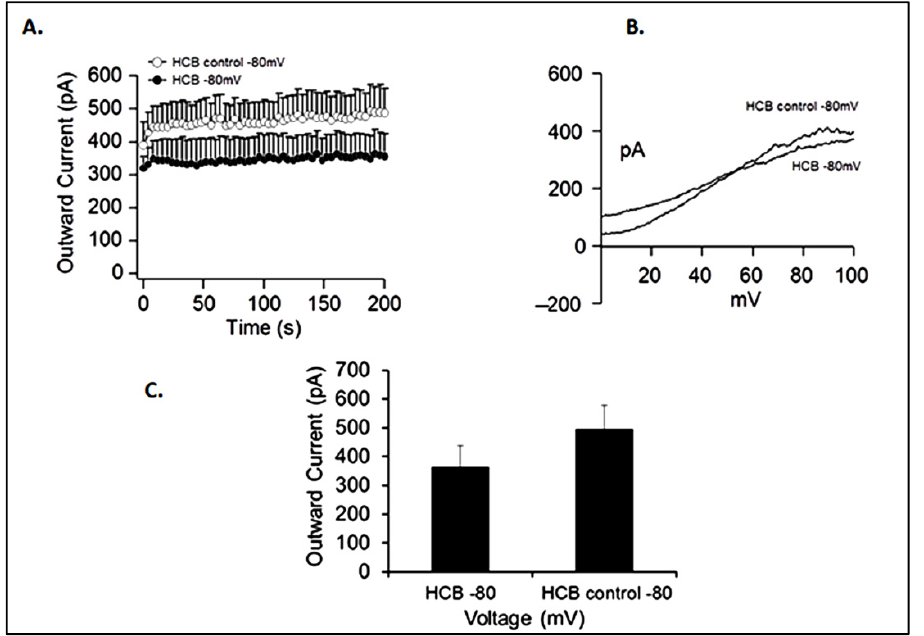
Figure 6. Effect of HCB on voltage-gated delayed rectifier K + currents in neurons obtained after encapsulation. ( A ) Average outward currents recorded from controls and HCB 0.5 nM treated cells extracted at +50 mV from a voltage ramp ranging from − 100 mV to +100 mV and − 80 mV holding potential (n = 4 cells/group; mean ± SEM). ( B ) Representative current-voltage relationship (I/V) from a cell from each group. ( C ) Average peak currents at 200 s after establishment of whole-cell configuration from panel A ( p < 0.05). These results indicate that, although HCB affects neurite outgrowth, it does not interfere with the expression of K + channels, which are typically present in mature